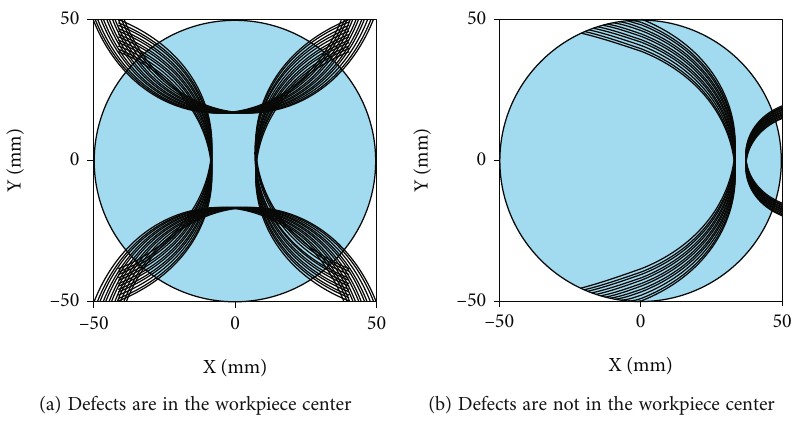
Figure 7: Wavefront arcs of rectangular defects at di ff erent positions.